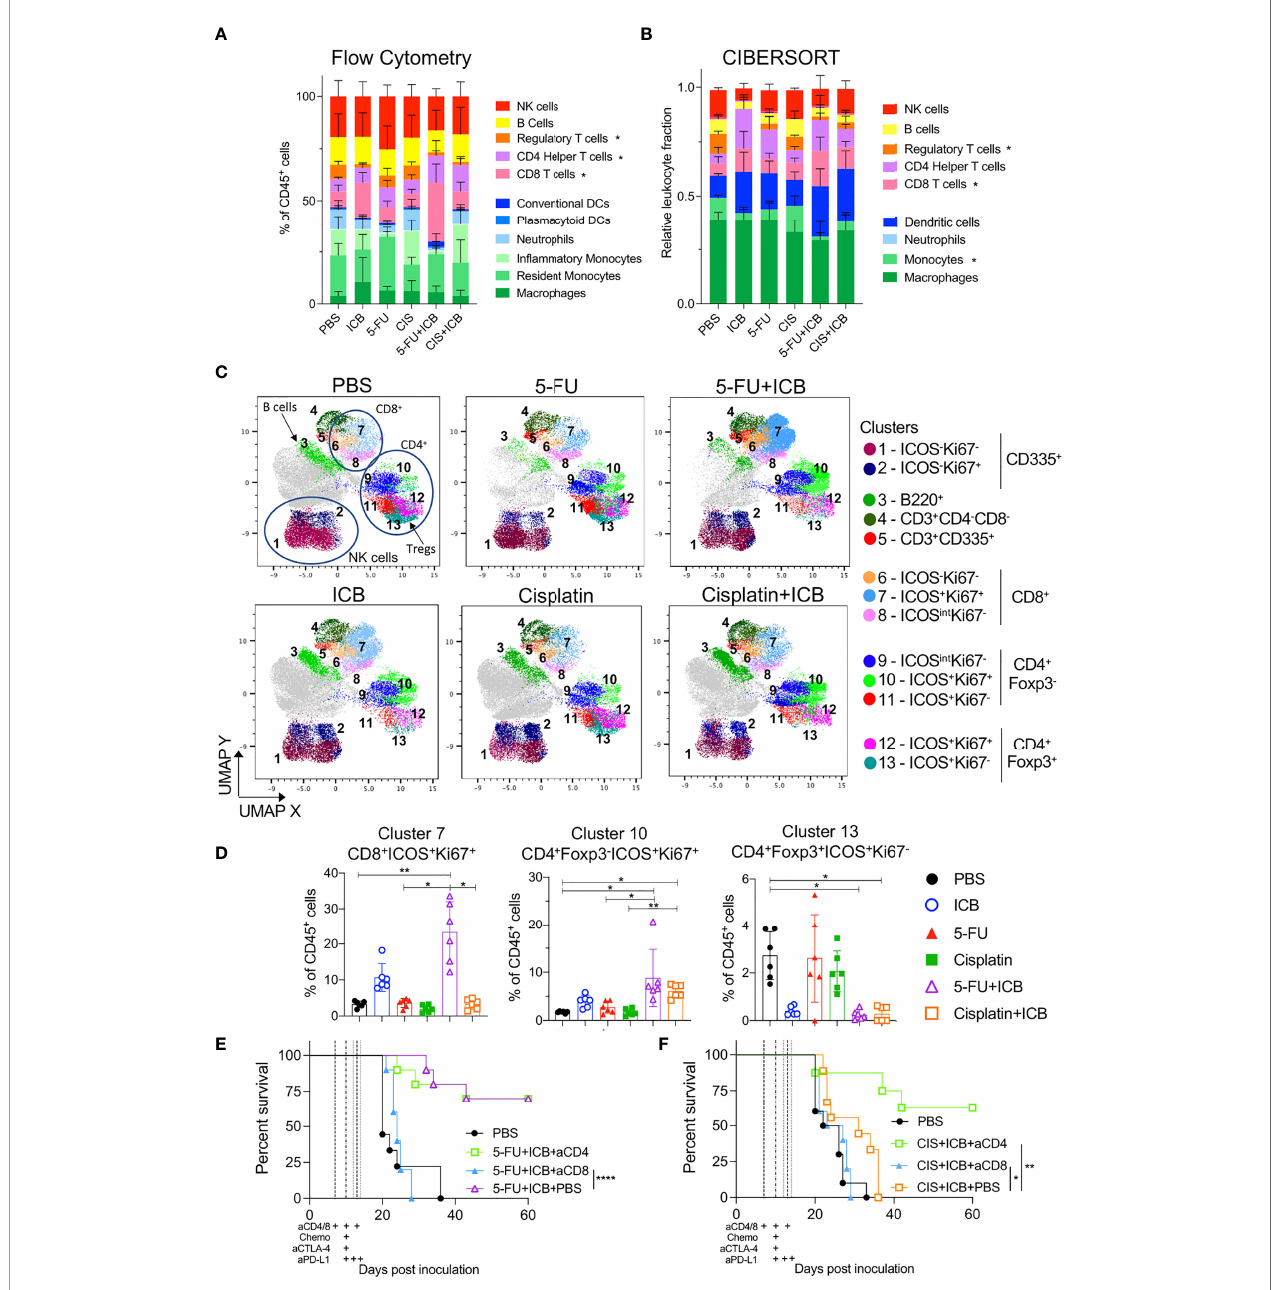
FIGURE 3 | Tumors of additive chemo-immunotherapy combinations are enriched for activated CD8 + and CD4 + T cells. (A, B) Summary of lymphoid and myeloid immune cell proportions in chemo-immunotherapy treated tumors analyzed using fl ow cytometry (A) and CIBERSORTx (B) from bulk RNAseq. * indicates p < 0.05 for that cell type between chemo-immunotherapy and PBS controls. (C) UMAP plots of clustered CD45 + cells from fl ow cytometry data for each treatment group. Cells are colored by Phenograph clusters and annotated by expression of phenotypic markers in legend. Cells colored in grey had no expression of other phenotypic markers in panel and were excluded from analysis. (D) Frequencies of cells from clusters 7.10,13 in all chemotherapy and/or ICB treated tumors. (E, F) Survival curves of AB1-HA tumor bearing mice treated with 5-FU+ICB (E) and cisplatin+ICB (F) with or without anti-CD4 or anti-CD8 depletion antibodies. Dotted lines indicate when therapies were administered. Data shown as mean ± SD, fl ow cytometry data is summary of two independent experiments (n = 6 per group), RNAseq data (n = 5 per group except PBS and cisplatin; n = 4 per group), in vivo tumor growth data is summary of two independent experiments (n = 10 per group). Mann- Whitney U test corrected for multiple comparisons and Mantel-Cox survival test; *P < 0.05, **P ≤ 0.01, ****P ≤